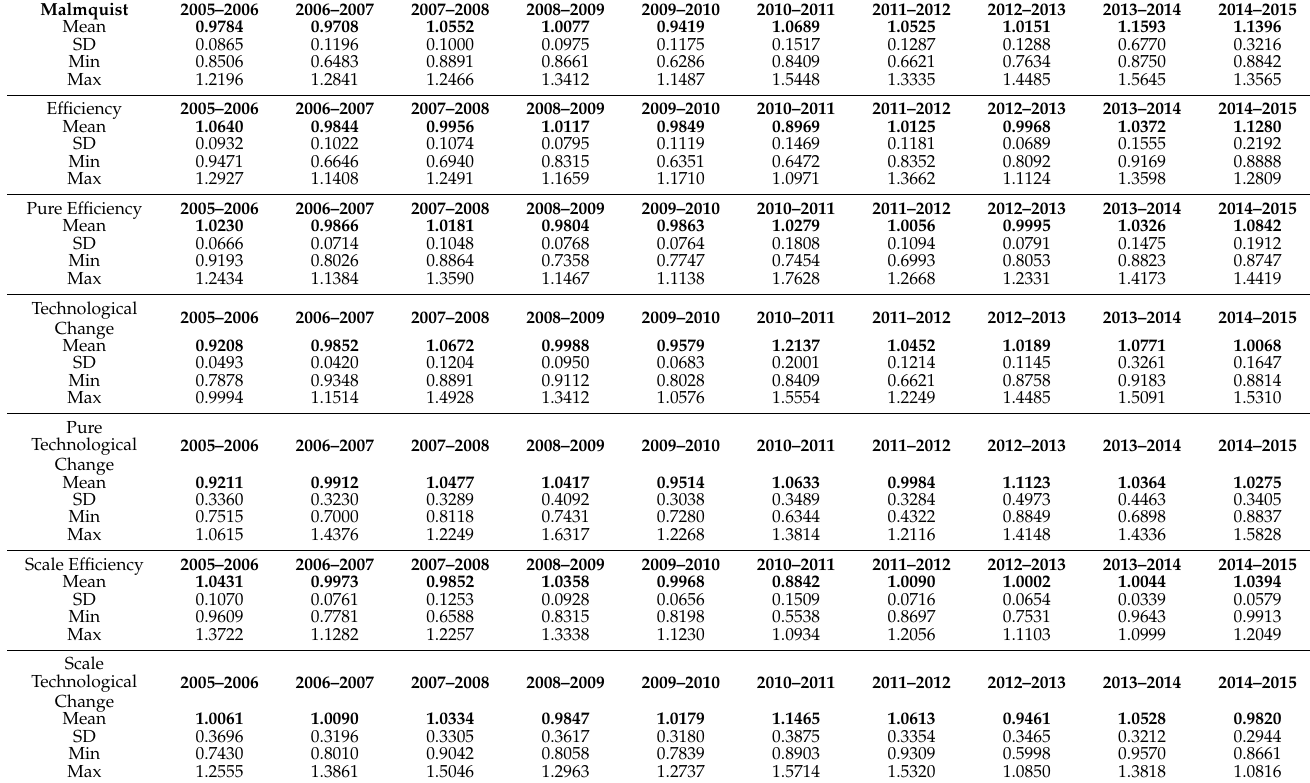
Table A2. Descriptive statistics of the Malmquist index and its components by